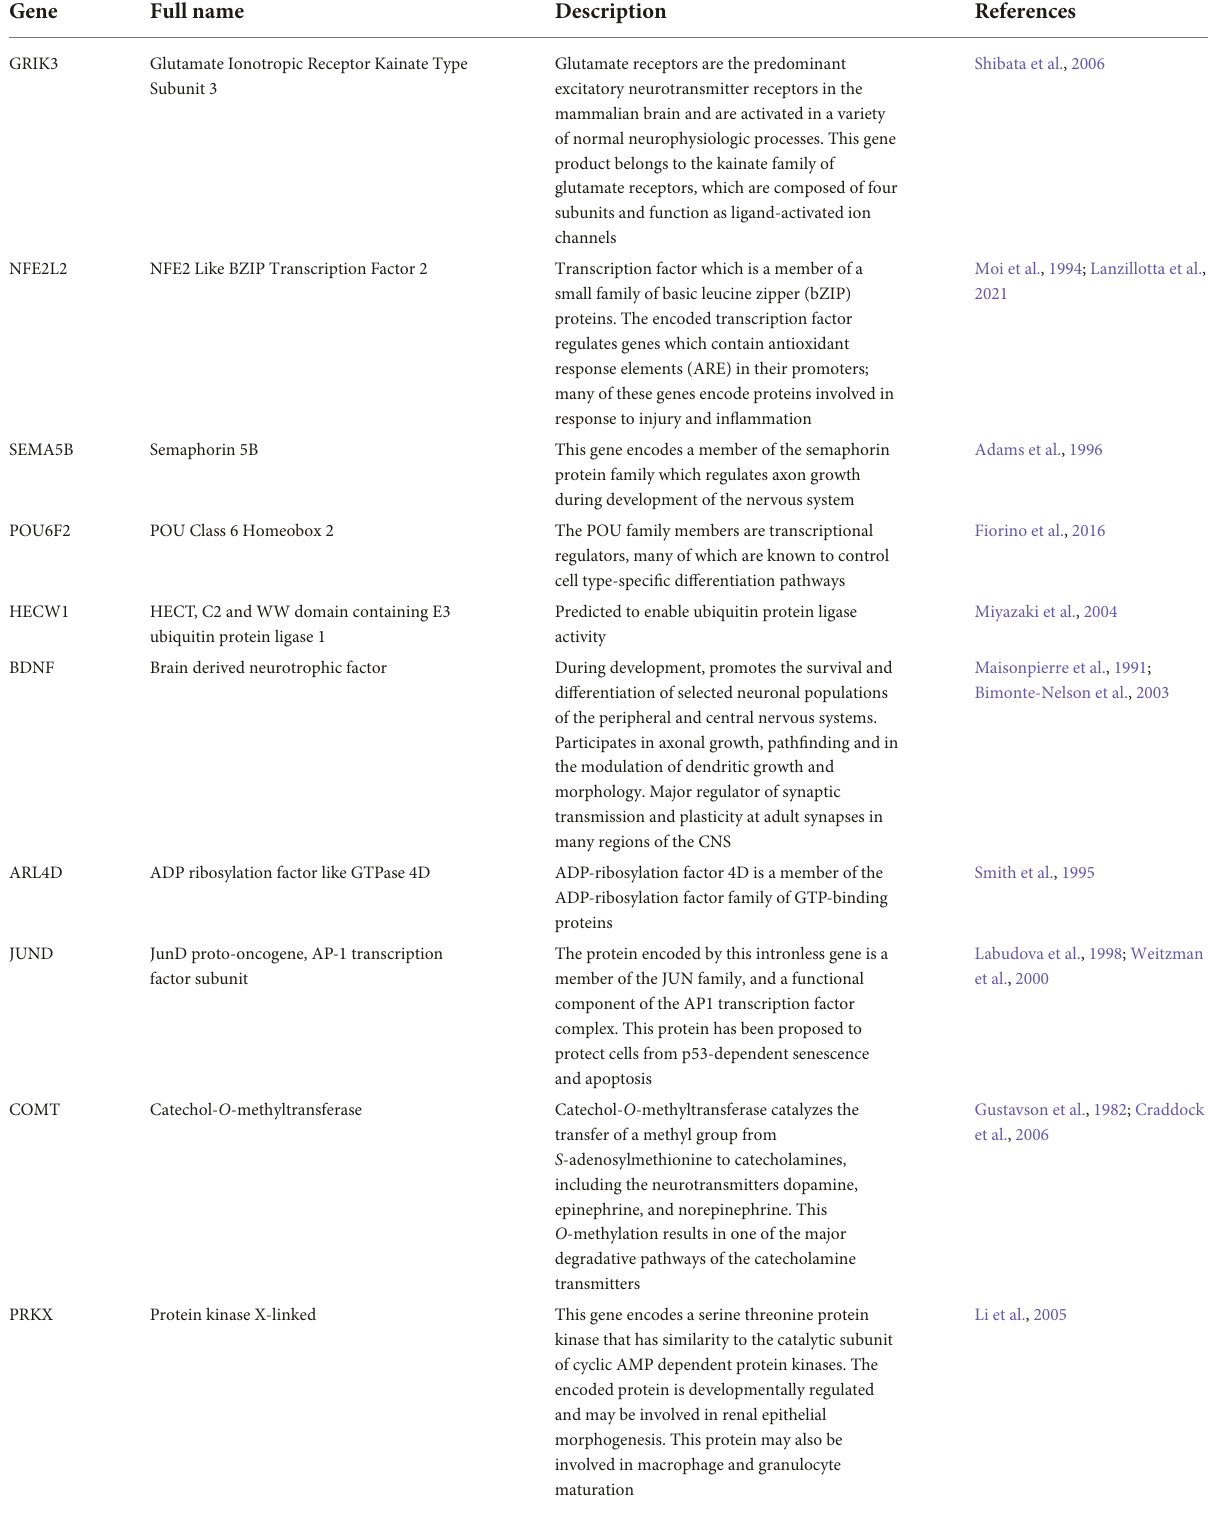
TABLE 3 Genes that are differentially expressed (DEX) in common across all four datasets: Olmos-Serrano et al. (2016), Palmer et al. (2021), and Klein et al. (2022), and the current scRNA-seq dataset generated for this study.